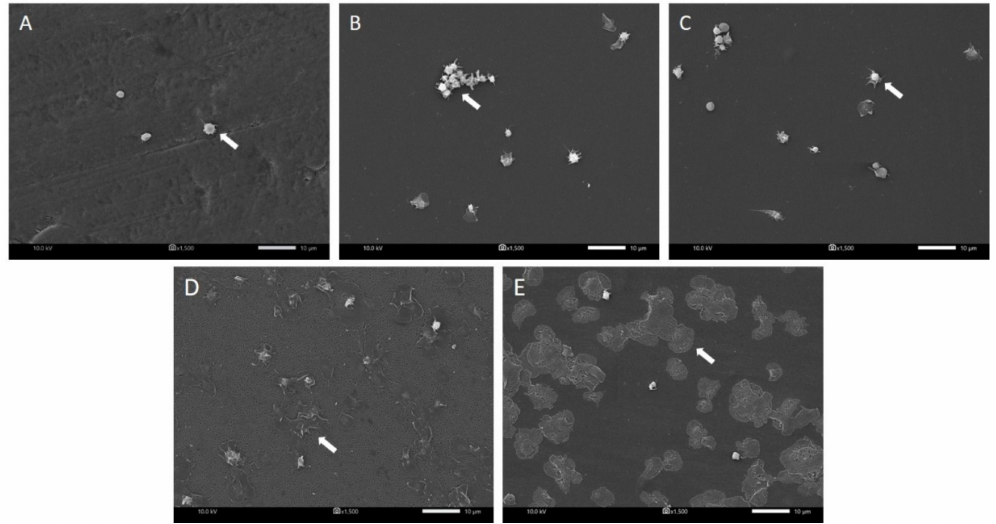
Figure 5. SEM images of adhered platelets on the samples including ( A ) PTFE, ( B ) SF, ( C ) 5, ( D ) 10, and ( E ) 15 Hep/SF films. White arrows indicate adhered platelets. Images were taken at the magnification of 1500X. Scale bars: 10 µ